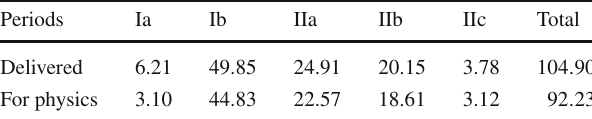
Table 5 Summary of the number of protons on target for each period. All the numbers are in units of 10 18 protons on target (POT)